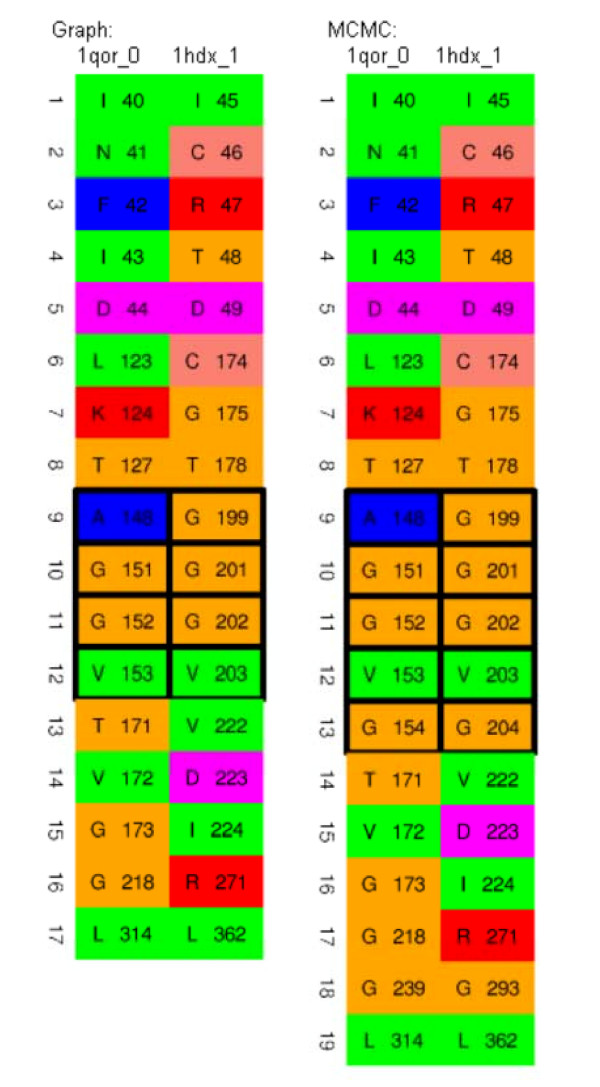
Corresponding amino acids between the NAD-binding site of alcohol dehydrogenase (1hdx_1) and NADP-binding site of quinone oxidoreductase (1qor_0) before and after MCMC refinement with the glycine rich motif highlighted (see main text) (Case 1).